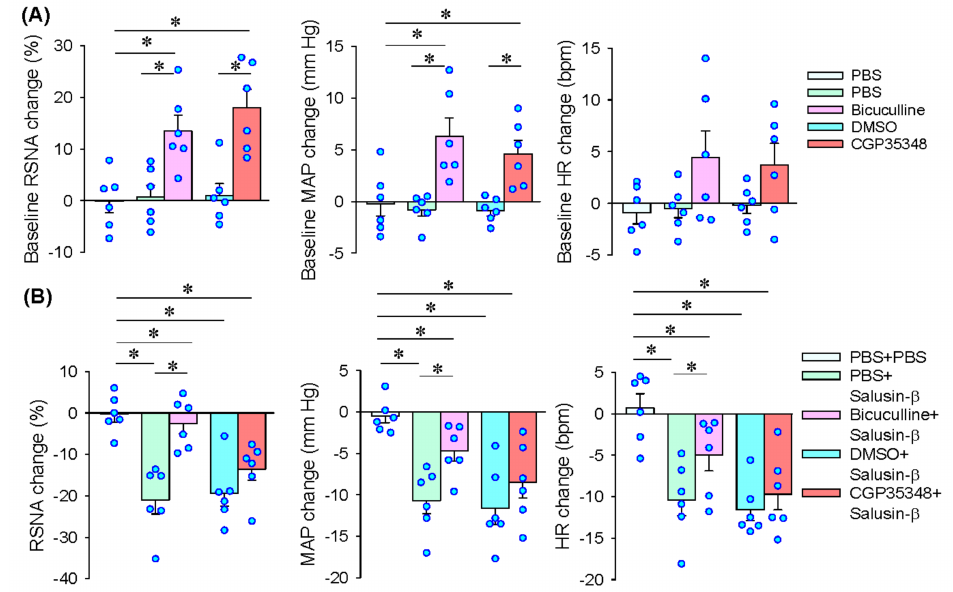
Figure 7. Roles of GABA receptors in the PVN in mediating the effects of salusin- β in iDMV. Microin- jection of salusin- β (100 pmol) in iDMV was carried out 10 min before microinjection of bicuculline (a GABAA receptor antagonist, 100 pmol) or CGP35348 (a GABAB receptor antagonist, 10 nmol) into the PVN. ( A ) Baseline RSNA, MAP and HR changes induced by bicuculline or hydrochloride in iDMV. ( B ) Effects of pretreatment with bicuculline or CGP35348 in the PVN on the roles of salusin- β in the iDMV. * p <